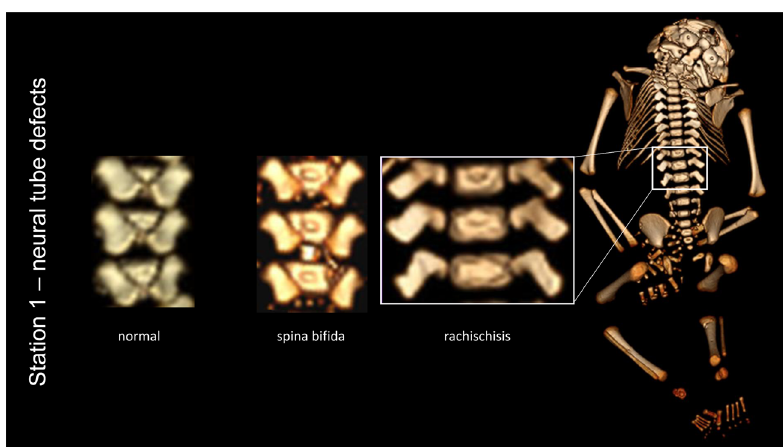
Fig. 2 Screenshot of the interactive information of neural tube defects using radiological imaging: vertebrae of a fetus with rachischisis can be compared to vertebrae of a normal fetus and a fetus with spina bifida